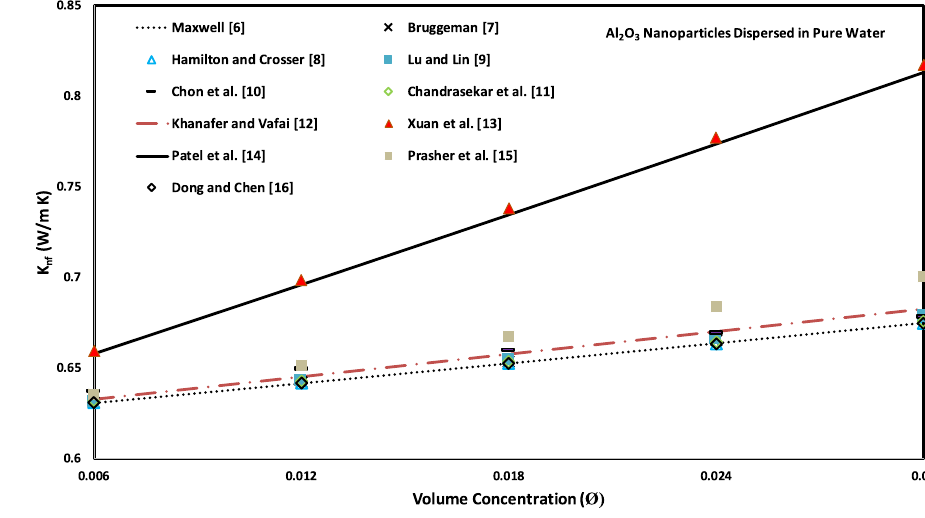
Fig. 8 Thermal conductivity of Al O /water nanofluid at dif- 2 3 ferent volume concentrations